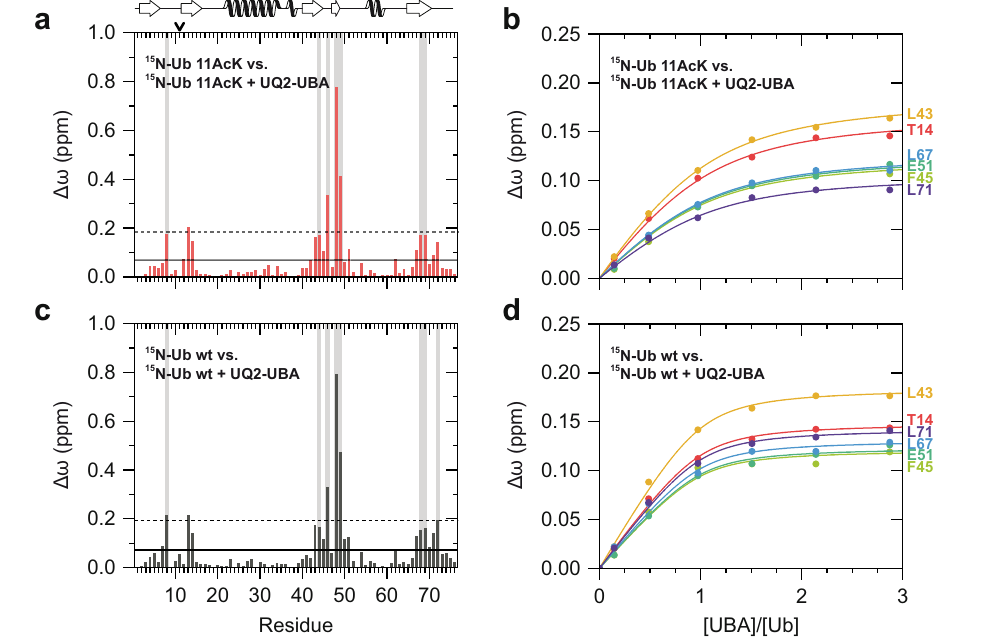
Fig. 4 | Structural differences between Ub 11AcK and nonmodi fi ed Ub result in different binding af fi nities for the UBA domain of Ubiquilin-2. a , c Weighted chemical shift perturbation (CSP, Δω ) mapping obtained at the endpoint of the NMR titration experiment of Ub 11AcK ( a ) and nonmodi fi ed Ub ( c ) with the UBA domain of Ubiquilin-2 (UQ2-UBA) in approximately three times molar excess. Values exceeding the horizontal solid line are higher than the mean, and values exceeding the horizontal dashed line are higher than the mean plus one standard deviation.Backgroundlinesingrayhighlightresiduesexperiencingmorethan90% decrease of signal intensity during the titration due to slow or intermediate